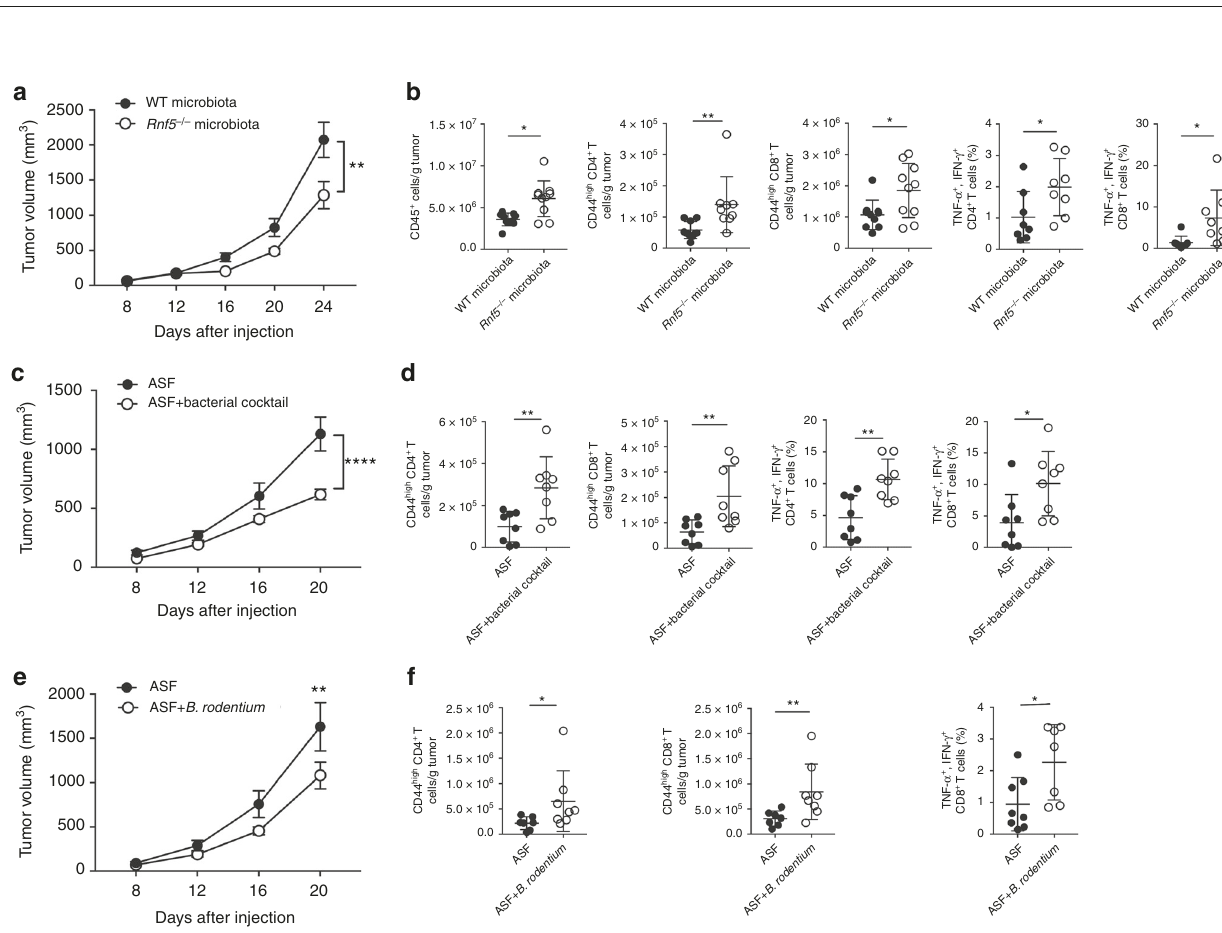
Fig. 4 Oral administration of select bacterial strains enriched in Rnf5 − / − mice to gnotobiotic mice enhances antitumor immune response. a YUMM1.5 tumor growth in germ-free (GF) mice undergoing oral gavage with WT or Rnf5 − / − cecal contents 2 weeks prior to tumor implantation ( n = 10). b Quanti fi cation of tumor-in fi ltrating CD45 + cells, effector (CD44 hi ) CD4 + and CD8 + T cells, total CD45 + cells, and frequencies of IFN- γ + TNF- α + -producing CD4 + and CD8 + T cells on day 24 after tumor injection in recipients treated as in ( a ) ( n = 10). c YUMM1.5 tumor growth in GF mice undergoing oral gavage with either Altered Schaedler Flora (ASF) or ASF plus bacterial cocktail prior to tumor inoculation (ASF, n = 12; ASF + bacterial cocktail, n = 14). d Quanti fi cation of tumor-in fi ltrating effector (CD44 hi ) CD4 + and CD8 + T cells and frequencies of IFN- γ + TNF- α + -producing CD4 + and CD8 + T cells on day 21 after tumor injection in mice treated as in ( c ) ( n = 8). e YUMM1.5 tumor growth in GF mice undergoing oral gavage with ASF or ASF plus B. rodentium prior to tumor inoculation ( n = 15). f Quanti fi cation of tumor-in fi ltrating effector (CD44 hi ) CD4 + and CD8 + T cells and frequencies of IFN- γ + TNF- α + -producing CD8 + T cells on day 24 after tumor injection in mice treated as in ( e ) ( n = 8). Data are one experiment ≥ 8 mice per group. Graphs are the mean ± s.e.m. * P < 0.05, ** P < 0.005, **** P < 0.0001 by two-way ANOVA with Tukey ’ s or Sidak ’ s correction for multiple comparisons ( a , c , e ) or two-tailed t test or Mann – Whitney U test ( b , d , f